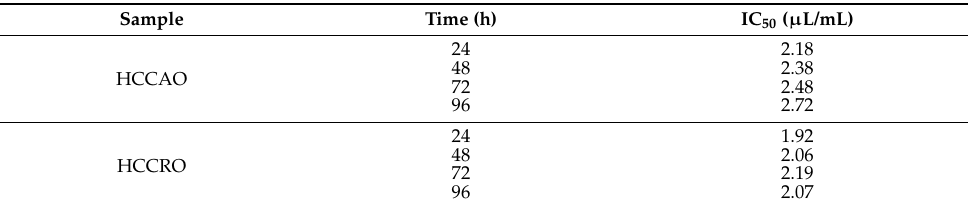
Table 5. IC 50 values of HCCAO and HCCRO on the egg hatching of Meloidogyne incognita .